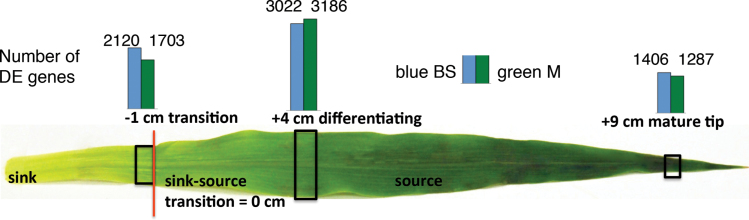
Developmental dynamics of BS/M differential expression (DE). Three sections from the third leaf of a 9-day-old maize plant representing locations of sink–source transition (SST), maturing, and mature developmental stages, the source material for BS and M LM capture. Details of sample site location, anatomy and ultrastructure are in Li et al. (2010) and Majeran et al. (2010). Blue bars above the leaf represent the number of DE genes found to be BS-biased and green bars represent the number of M-biased DE genes.